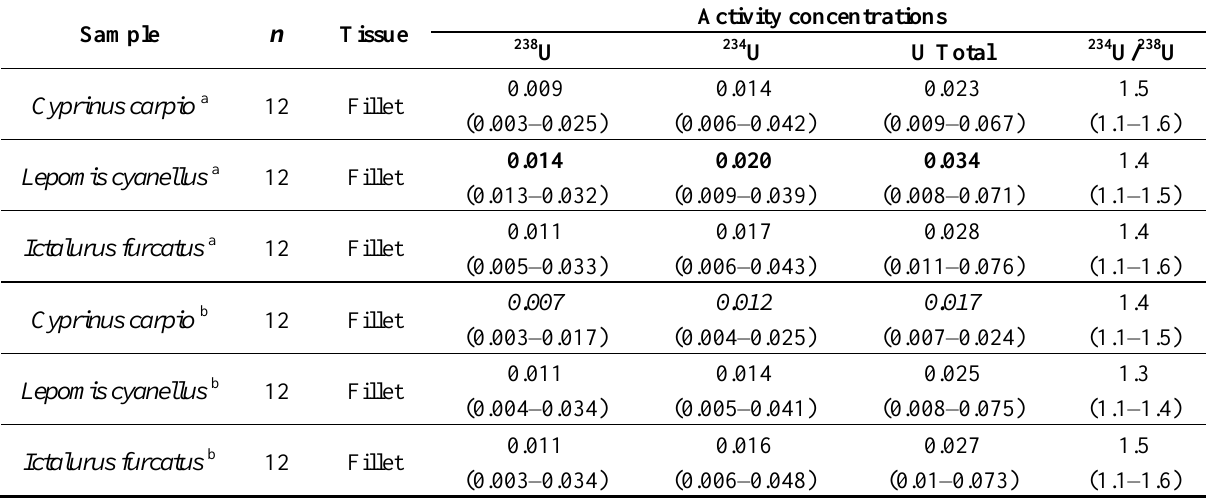
Table A1. Geometric Mean values of uranium isotope AC in fish fillet (Bq∙kg −1 ww) and activity ratios for fish sampled at Luis L. Leon